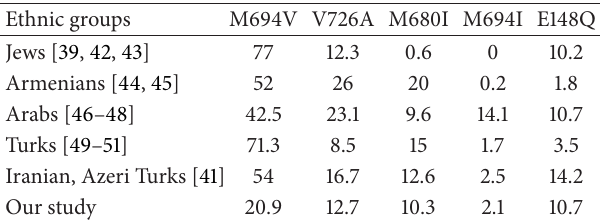
Table 5: Comparison of different ethnics’ studies. Ethnic